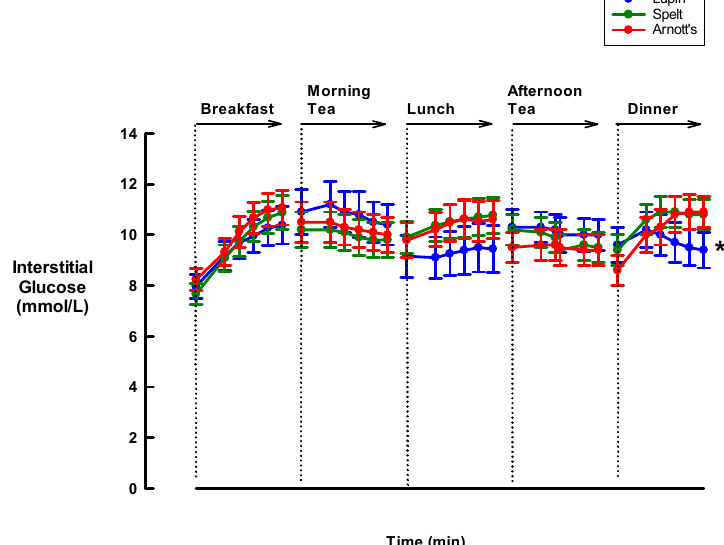
Figure 2. Effect of three different biscuits on interstitial glucose levels of Type-2 Diabetes Mellitus (T2DM) hospital inpatients during mid-meals and main meals. The figure presents results from repeated measures ANOVA reporting the between-group differences in mean interstitial glucose levels at each time point (treatment effect), the within-group changes in interstitial glucose levels from pre-prandial to all post-prandial time points (time effect) and the between-group differences in the changes from time (T)-0 to T-90 min (treatment x time interaction effect) at breakfast, morning tea, lunch, afternoon tea and dinner. All statistical analyses were controlled for the amount of carbohydrates consumed at each meal. The figure presents mean values (dots) and relevant standard errors of the means (whiskers). (* p < 0.001 in the comparison of the differences in interstitial glucose changes from pre-prandial to 90 min post-prandial, among the three treatments arms.)